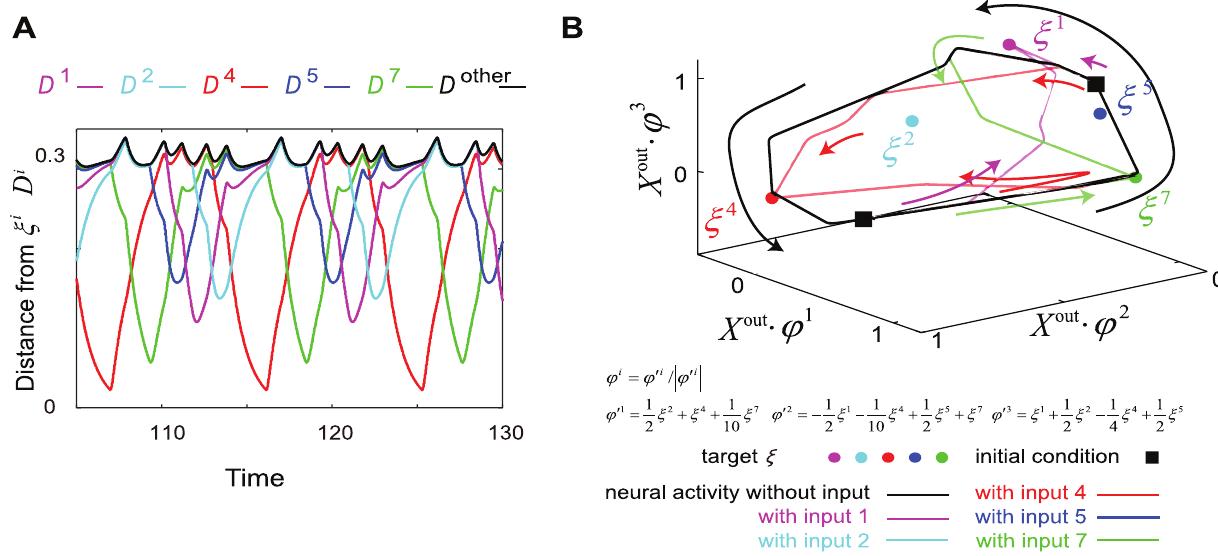
Figure 8. Temporal evolution of neural activity when the attractor without inputs is a limit cycle. The spontaneous neural dynamics and the evoked one after learning eight I/O mappings are plotted, same as Fig. 7. A) The time courses of the distance between the neural activity of the output and each target are plotted. Notations are same as Fig. 7 A. The time courses after transient time are plotted for focusing on limit-cycle attractor. B) Neural activity in the output layer is represented as a locus in a three-dimensional space, projected from the N -dimensional space consisting of neural activities in the output layer, by obtaining the product of the output activity and the combined target pattern(s). Each axis represents the product of the neural activity and the corresponding combined target patterns w , defined in the figure. Plotted by using the same notations used in Fig. 7. The black curve is not a transient orbit but a limit cycle in the absence of inputs. The colored curves represent the transient trajectories when inputs are applied under two initial conditions (black squares), which are not the initial conditions for the limit cycle. In the presence of an input, the limit-cycle attractor collapses, and the neural activities reach fixed points, giving rise to the corresponding target outputs. These fixed points are represented by circles in different colors, while transient trajectories from only two initial points are shown here. However, trajectories from all points on the limit-cycle reach the corresponding target with the application of a given input. On the other hand, the limit cycle attractor in the absence of inputs approaches and deviates from the points matching the targets, which are fixed points in the presence of inputs as mentioned above. The bifurcation from the spontaneous limit-cycle attractor to the evoked fixed-point attractor is plotted in detail in Fig. 12.